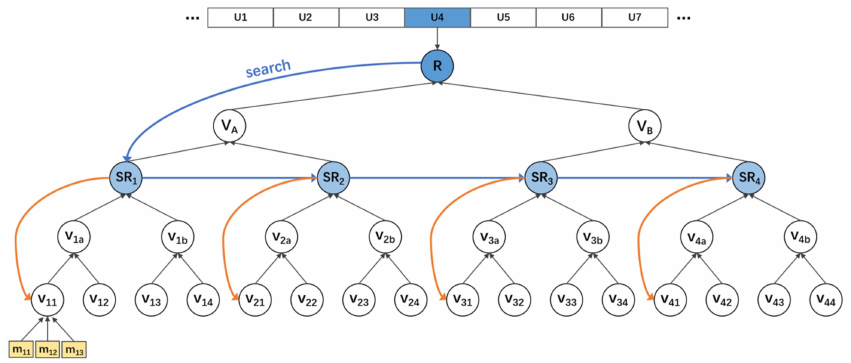
Figure 2. The structure of the hierarchical Merkle hash tree.